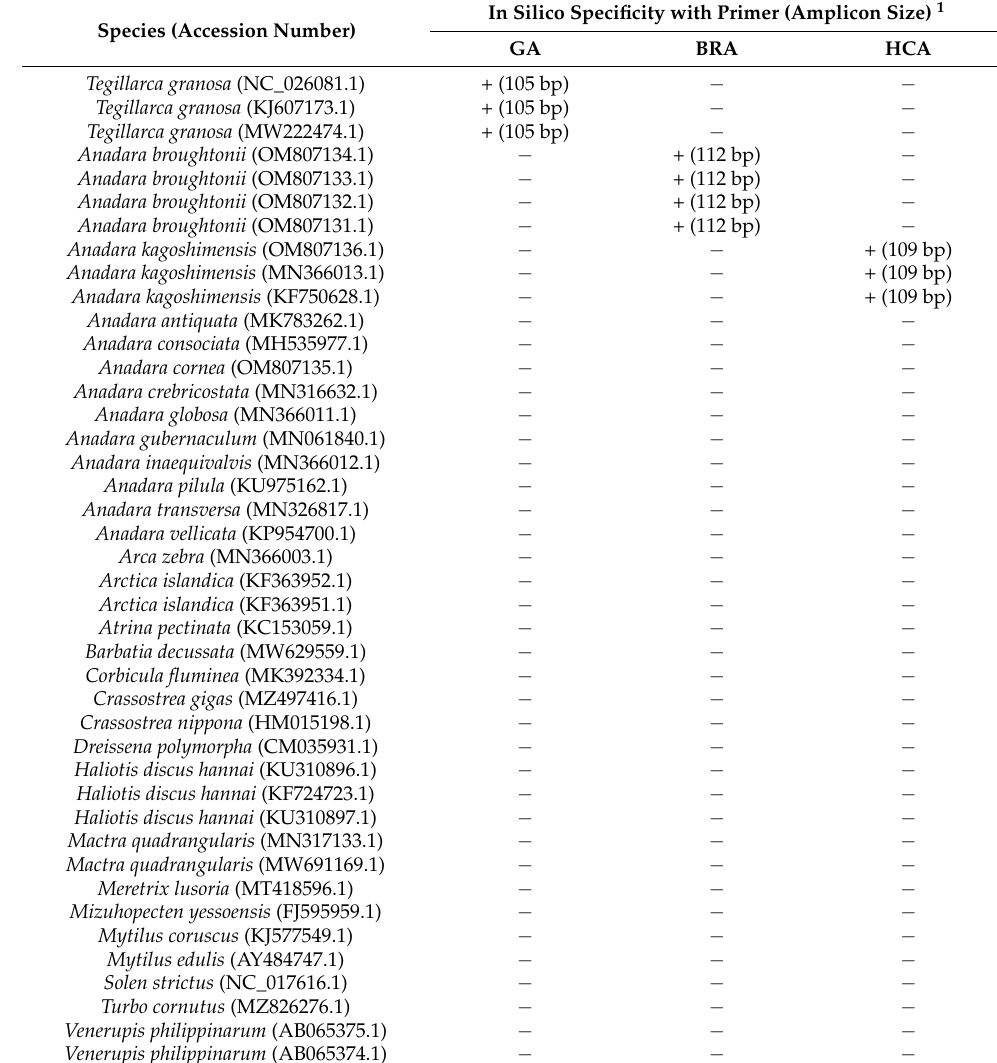
Table 2. In silico specificity for three species-specific primer pairs using in silico PCR program. Species (Accession